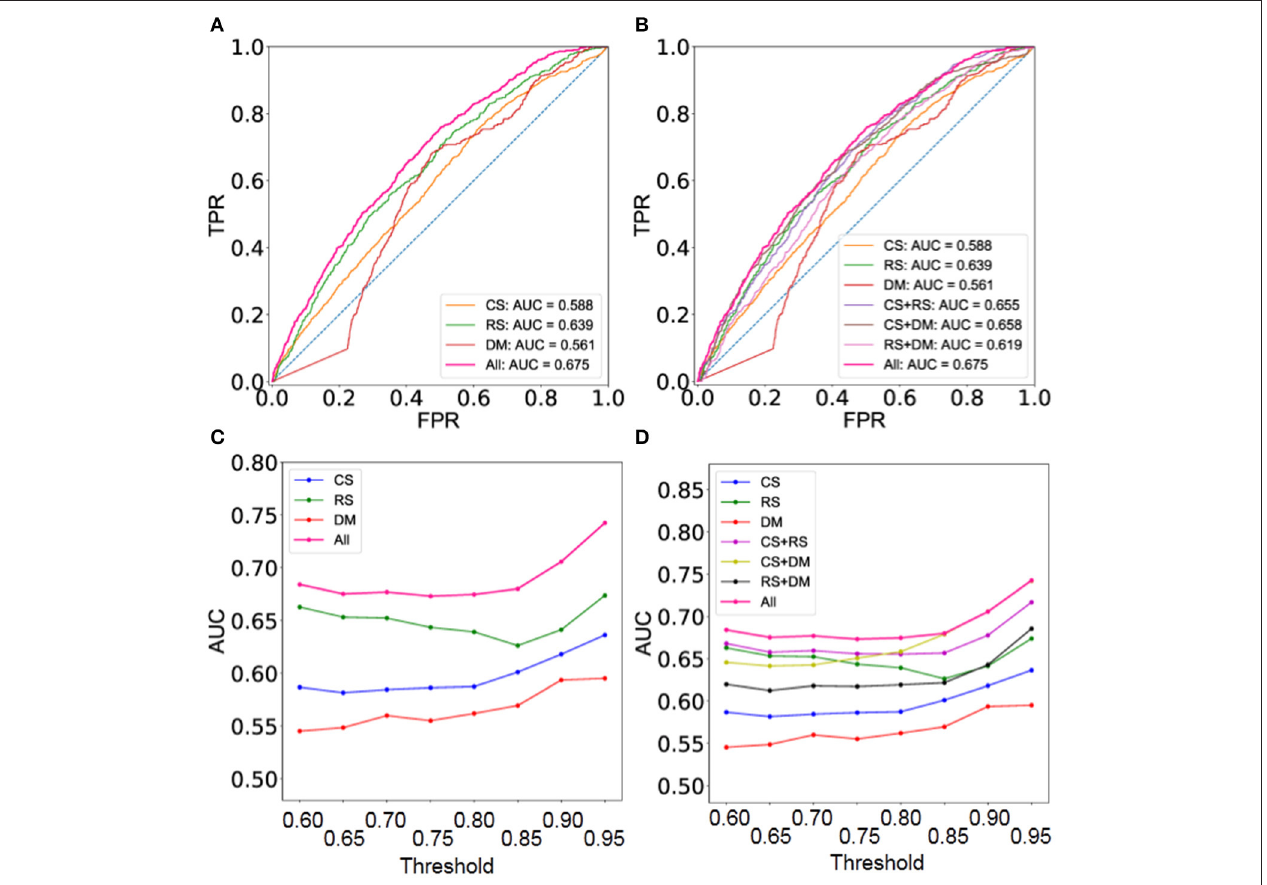
FIGURE 3 | Performance evaluation using the set of gold standard TF interactions based on 41 cell type TF regulatory networks. (A) ROC curves of the integrated and three individual networks at threshold = 0.8. (B) ROC curves of the integrated networks, three individual ones and integrated ones with any two datasets at threshold = 0.8. (C) AUC of the integrated and three individual networks at different thresholds. (D) AUC of the integrated networks, three individual ones and integrated ones with any two datasets at different